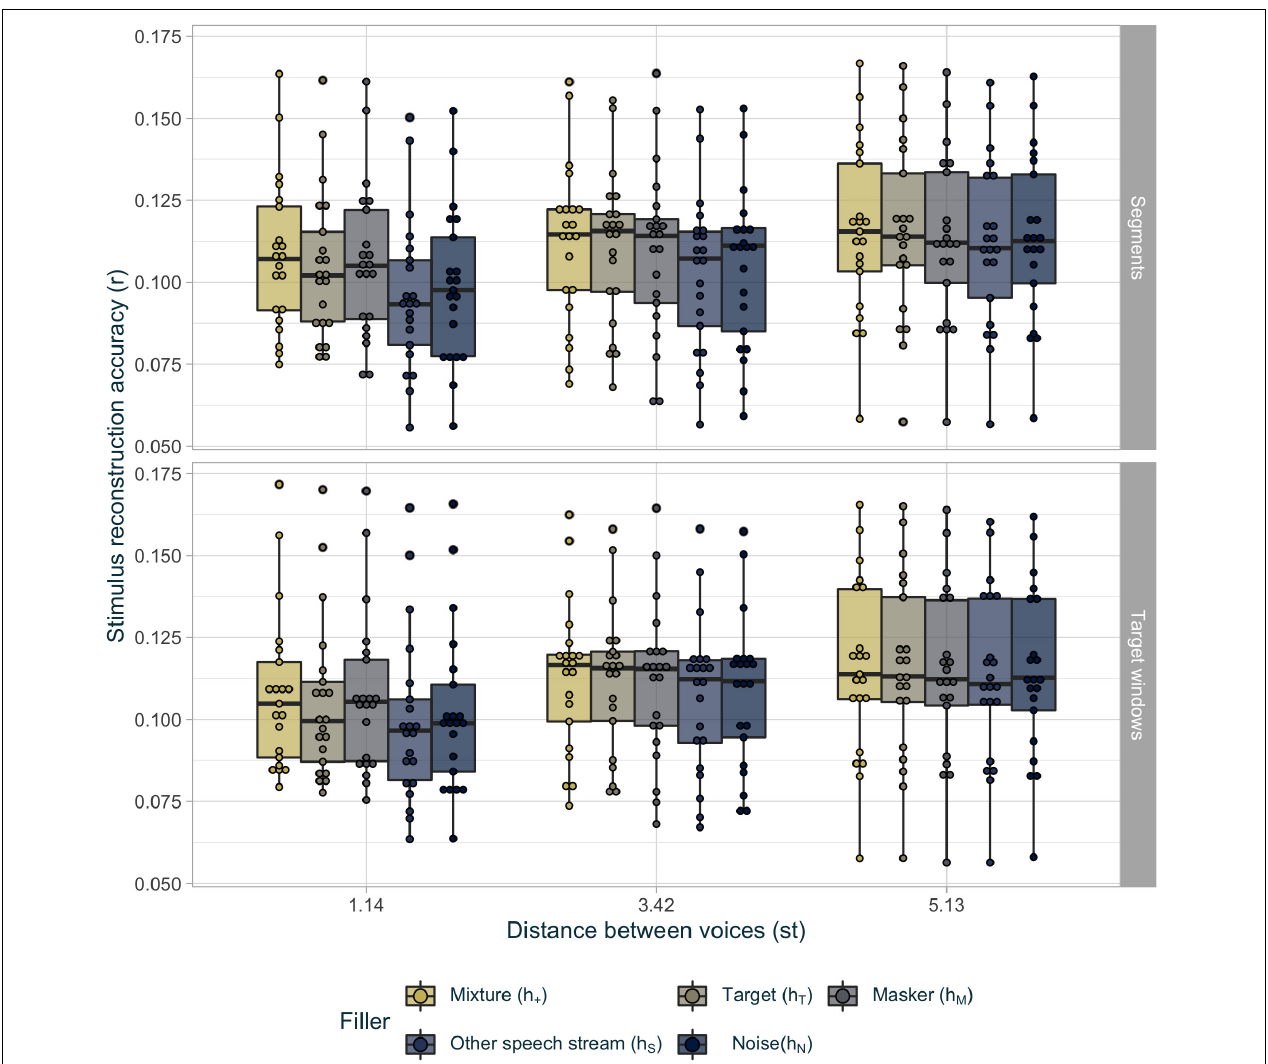
FIGURE 4 | Average reconstruction accuracy r for inferred envelopes per condition. The points represent the scores for every participant in each voice condition for the extraneous keyword (in color) and the attentional scope (top and bottom). The hinges of the boxplot represent the first and the third quartile. The median is represented as a bar in each boxplot. The whiskers extend over 1.5 times the interquartile